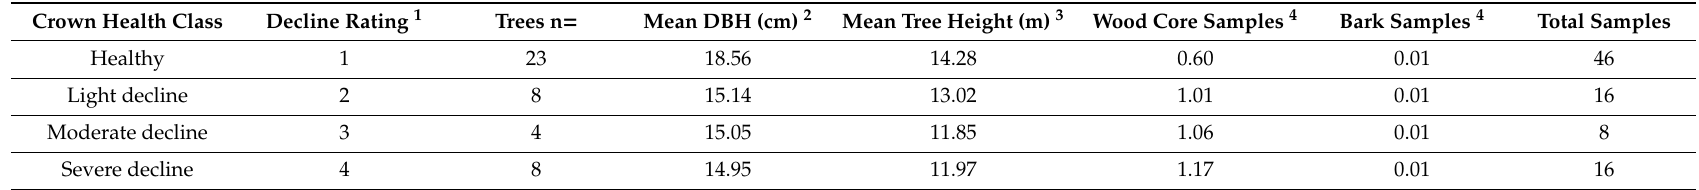
Table 1. Green ash test-tree and sample characteristics (metadata), and numbers of samples chemically